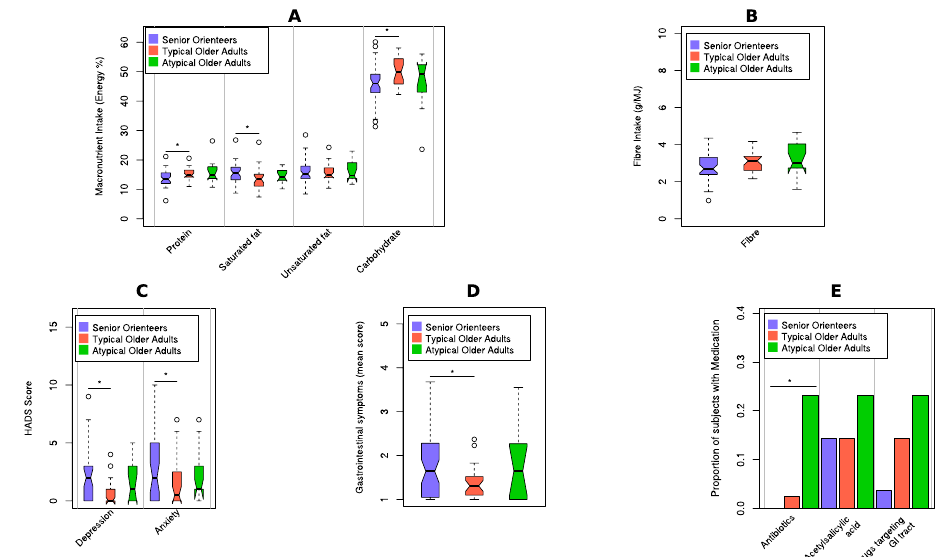
depicts groups, and blue scale codes for the gastrointestinal symptom scores measured with Gastrointestinal Symptom Rating Scale (GSRS) values. Dotted ellipse indicates 95% confidence region of older adults and dashed ellipse indicates 95% confidence region of senior orienteers. CEA = 95% confidence ellipse area. (A) PCoA using all predicted species; (B) PCoA using four selected species that were significantly different between older adults and senior orienteers.